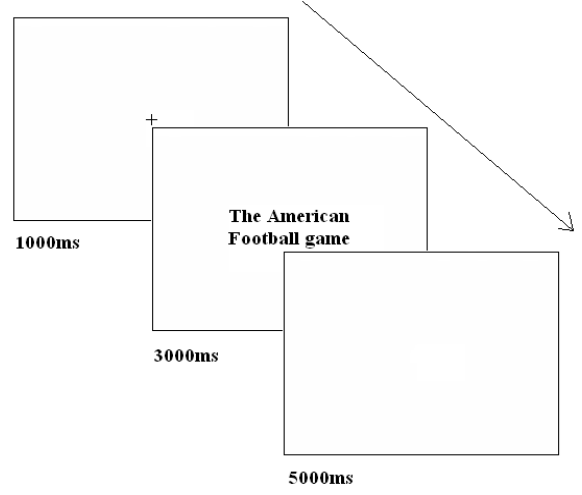
Figure 4: A diagrammatic representation of the delayed imagery task in both the ‘imagery prior to recognition’ and the ‘recognition prior to imagery’